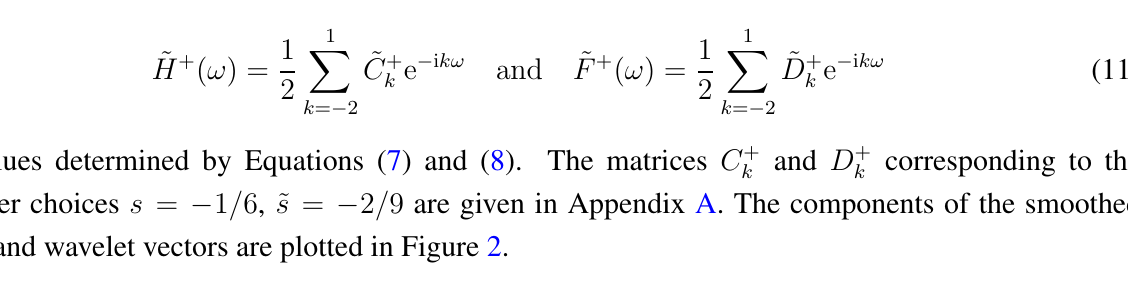
Figure 2. Smoothed scaling vector ˜ Φ + and multiwavelet ˜ Ψ +